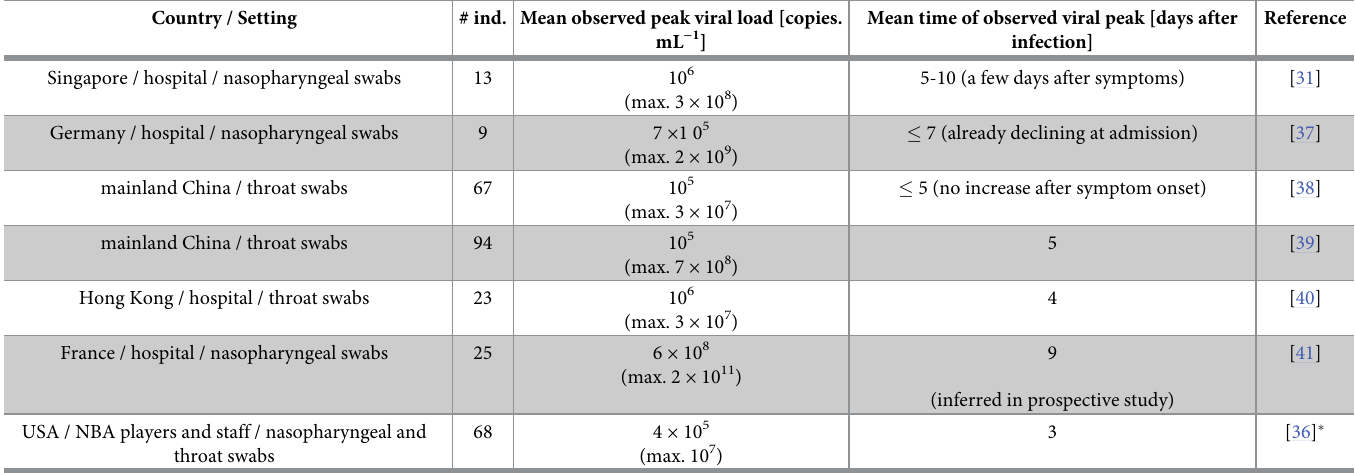
Table 1. Literature review of SARS-CoV-2 viral load trajectories within hosts. Country /